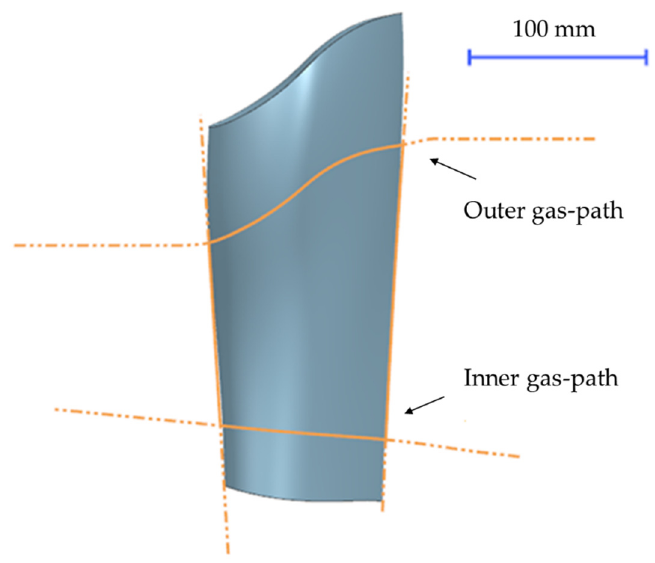
Figure 2. Airfoil created in space between gas path surfaces.